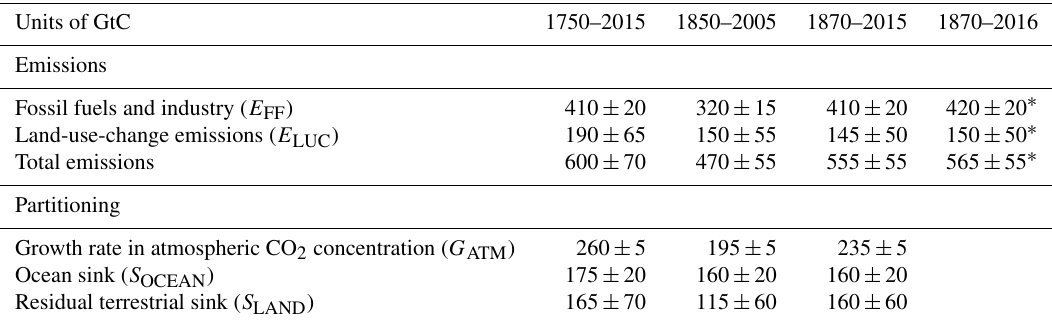
Table 10. Cumulative CO 2 emissions for different time periods in gigatonnes of carbon (GtC). We also provide the 1850–2005 time period used in a number of model evaluation publications. All uncertainties are reported as ± 1 σ . All values are rounded to the nearest 5GtC as in Stocker et al. (2013), reflecting the limits of our capacity to constrain cumulative estimates. Thus, some columns will not exactly balance because of rounding